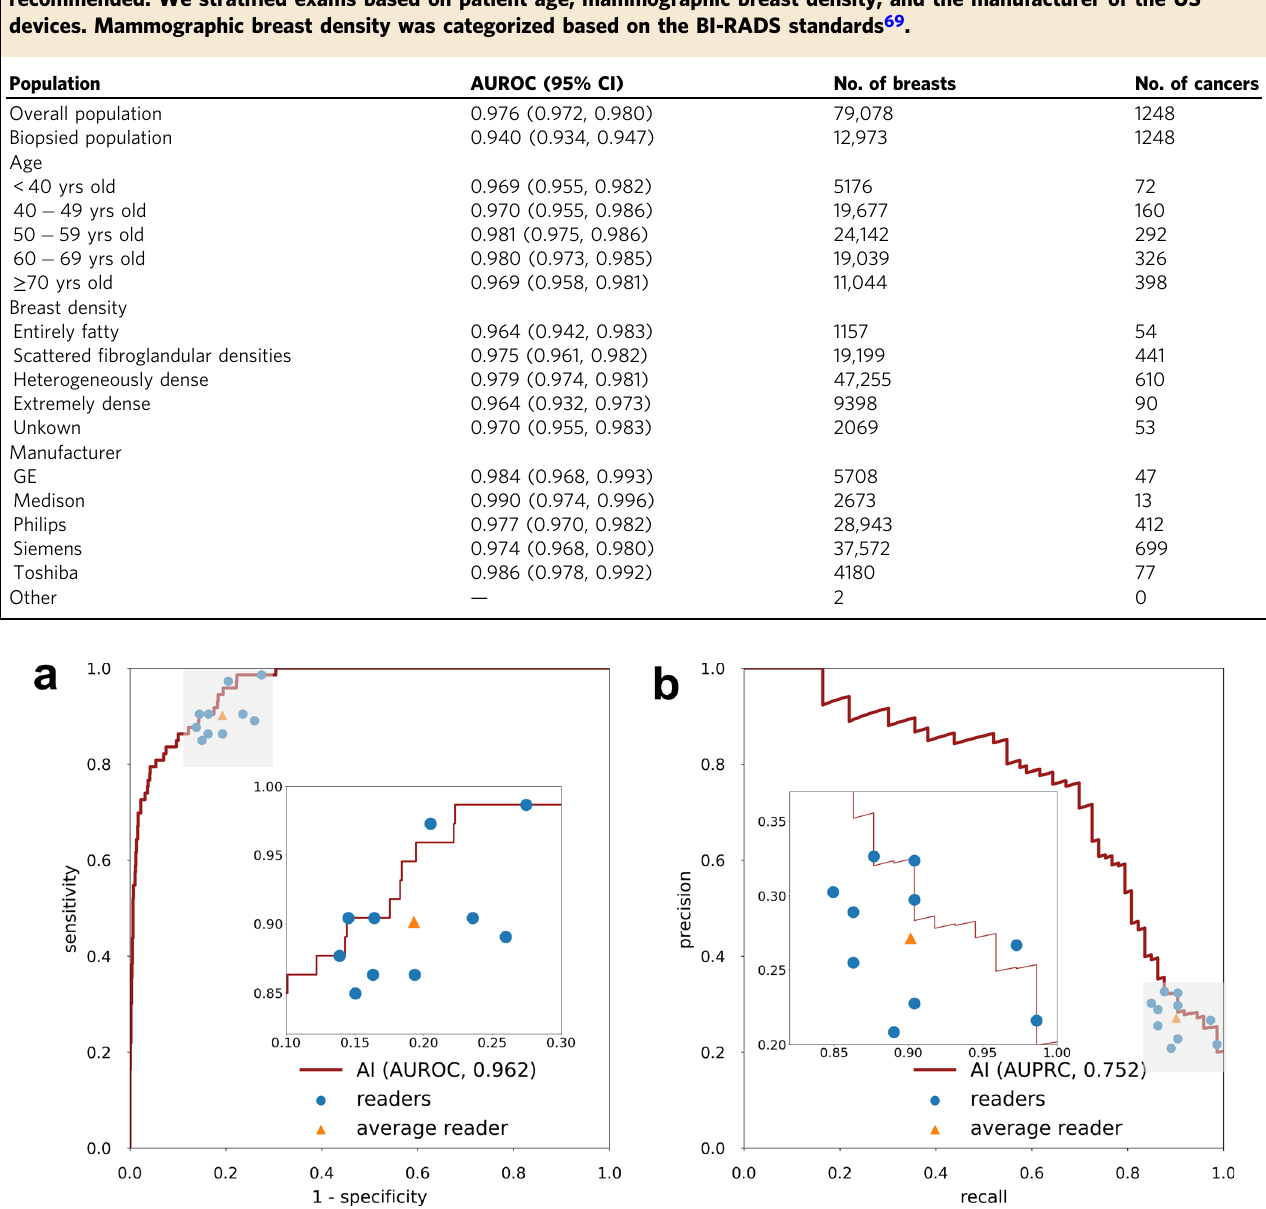
Fig. 2 Reader study results. The performance of the AI system on the reader study population ( n = 1024 breasts) using ROC curve ( a ) and precision-recall curve ( b ). The AI achieved 0.962 (95% CI: 0.943, 0.979) AUROC and 0.752 (95% CI: 0.675, 0.849) AUPRC. Each data point represents a single reader and the triangles correspond to the average reader performance. The inset shows a magni fi cation of the gray shaded